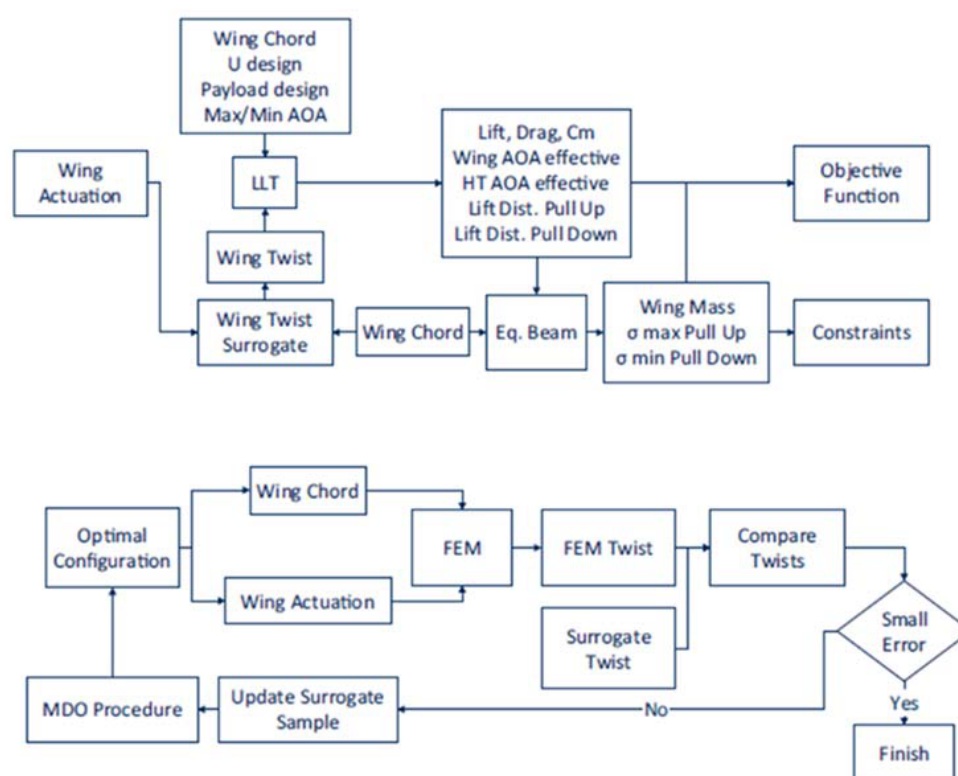
Figure 2. Data flow for calculations during the actuation distribution optimization procedure. Data generation for objective function and constraints calculation (up); surrogate twist and FEM twist results comparison and surrogate model update procedure (down) (reproduced from [26]).